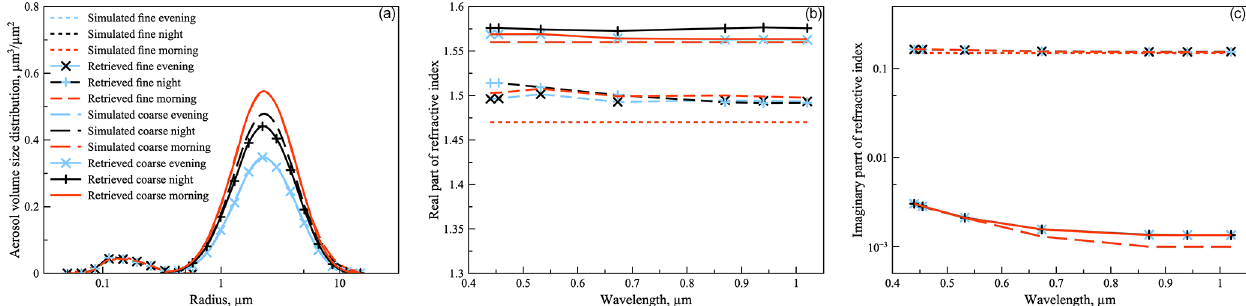
Figure 2. Aerosol volume size distributions (a) , real (b) and imaginary parts (c) retrieved from simulated data depicting monotonic change in aerosol coarse-mode concentration.